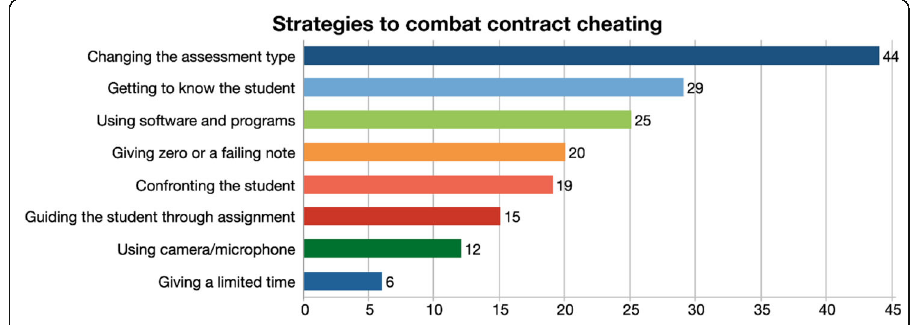
Fig. 4 Strategies to combat contract